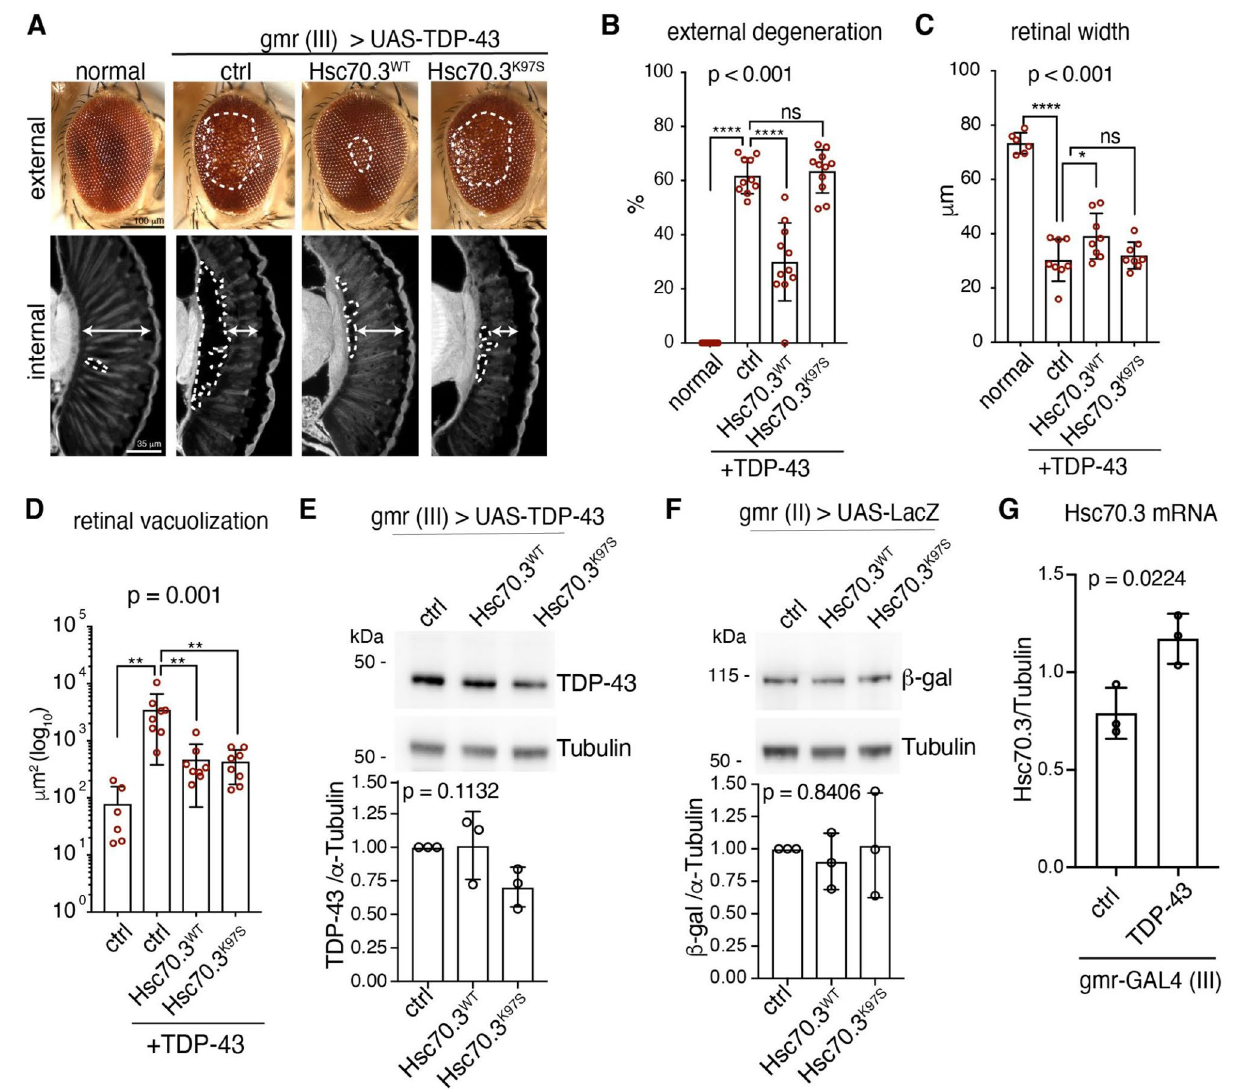
Figure 4. Upregulation of Hsc70.3 mitigates TDP-43-induced toxicity in the Drosophila eye. ( A ) Compared to the normal control, expression of human TDP-43 (ctrl) in the Drosophila eye disrupts the external eye (white hatched line, top panel) and internal retina (white double headed arrow, and white hatched line lower panel). ( B ) Expression of Hsc70.3 suppresses TDP-43-induced disruption of the external eye. Data is presented as Mean ± SD, one way ANOVA and a Fisher’s LSD test. ****P < 0.0001 and ns not significant. ( C ) Expression of Hsc70.3 WT suppresses TDP-43-induced reduction of retinal width (see double headed arrow, lower panel in A). Data is presented as Mean ± SD, one way ANOVA and a Fisher’s LSD test. ****P < 0.0001, *P < 0.05 and ns not significant. ( D ) Expression of Hsc70.3 WT , and Hsc70.3 K97S reduces TDP-43-induced vacuolization of the internal eye (white hatched line, lower panel in A.). Data is presented as Mean ± SD, one way ANOVA and a Fisher’s LSD test. ****P < 0.0001, *P < 0.05 and ns not significant. ( E ) Upregulation of Hsc70.3 WT or Hsc70.3 K97S had no effect of the total protein levels of TDP-43. Protein isolated from ~ 5 to 10 male heads immunoblotted for TDP-43 and Tubulin. Protein levels were quantified from 3 independent biological repeats. Data is presented as Mean ± SD, one-way ANOVA and Tukey’s test, ns not significant. ( F ) Upregulation of Hsc70.3 WT or Hsc70.3- K97S had no effect of the total protein levels of β-galactosidase. Protein isolated from ~ 5 to 10 male heads immunoblotted for β-galactosidase and Tubulin. Protein levels were quantified from 3 independent biological repeats. Data is presented as Mean ± SD, one-way ANOVA and Tukey’s test, ns: not significant. ( G ) Expression of TDP-43 with gmr-GAL4 leads to an increase in Hsc70.3 mRNA levels compared to control (ctrl). Data is presented as Mean ± SD. An unpaired and two-tailed T test was used to determine significance. Genotypes are ( A–E ) normal is y, sc, v, sev/w 1118 ; + / + ; gmr-GAL4 (YH3)/si.mCherry 35783 , ctrl is y, sc, v, sev/w 1118 ; UAS-TDP-43/ + ; gmr-GAL4 (YH3)/ si.mCherry 35783 , Hsc70.3 WT is w-; UAS-TDP-43/ UAS-Hsc70-3 WT ; gmr-GAL4 (YH3)/ + and Hsc70.3